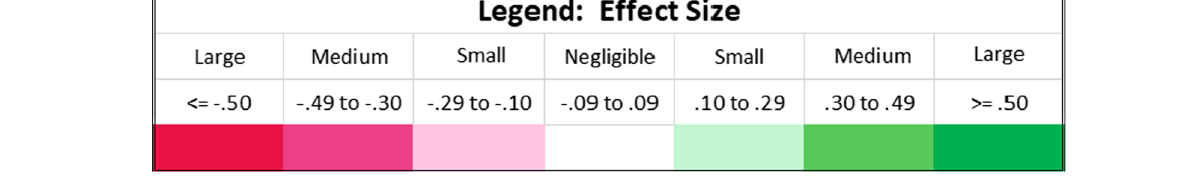
Close-Ended Rating Scale Goal